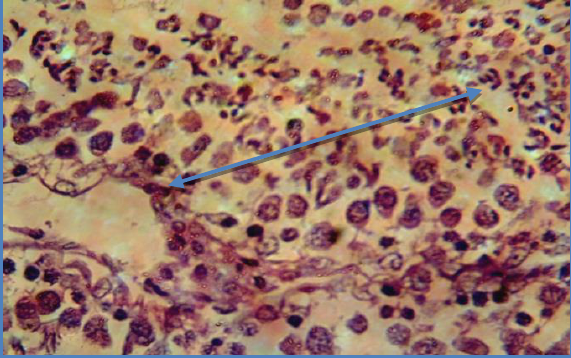
Figure, 2: Cross section of the rat testes of group T1 showing incomplete spermatogenesis with cellular debris in the lumen of seminiferous tubules (H and E stain 40 x).